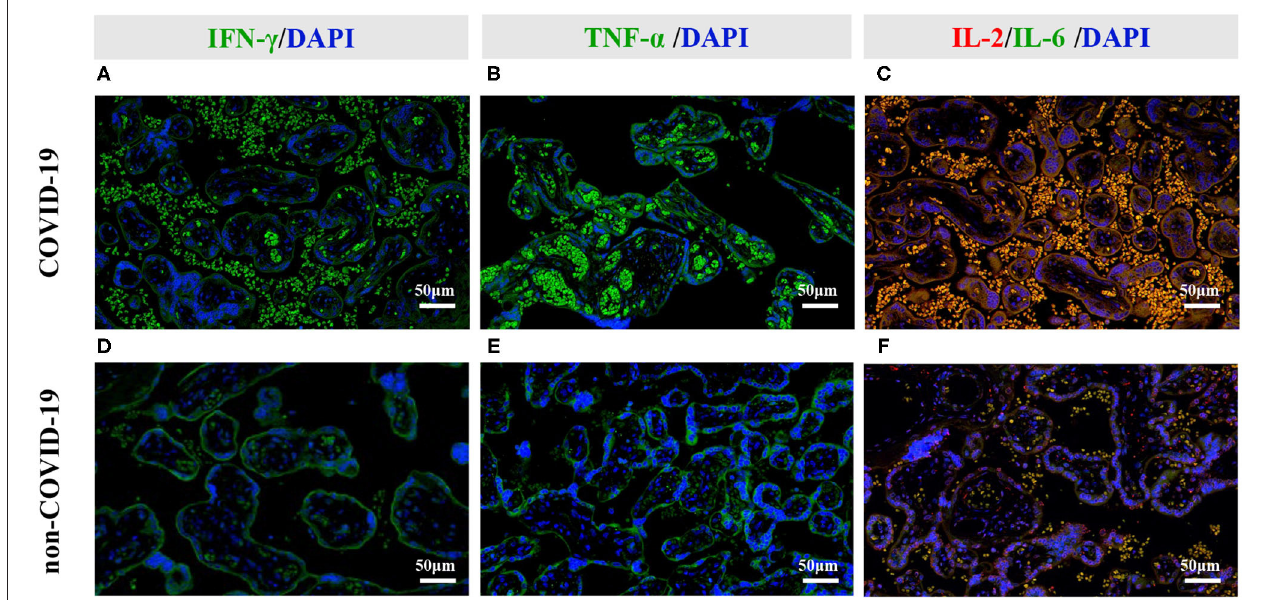
FIGURE 4 | Representative photomicrographs of the immunofluorescent staining of IL-2, IL-6, IFN- γ , and TNF- α in the placental tissues. (A–C) Immunofluorescent staining of COVID-19 placentas. (D–F) Immunofluorescent staining of non-COVID-19 placentas. (A,D) Increased IFN- γ signal was primarily co-localized with maternal blood in COVID-19 placentas. (B,E) Increased TNF- α signal was primarily co-localized with placental trophoblast cells in COVID-19 placentas. (C,F) Increased IL-2 and IL-6 signals were primarily co-localized with the maternal blood in COVID-19 placentas.